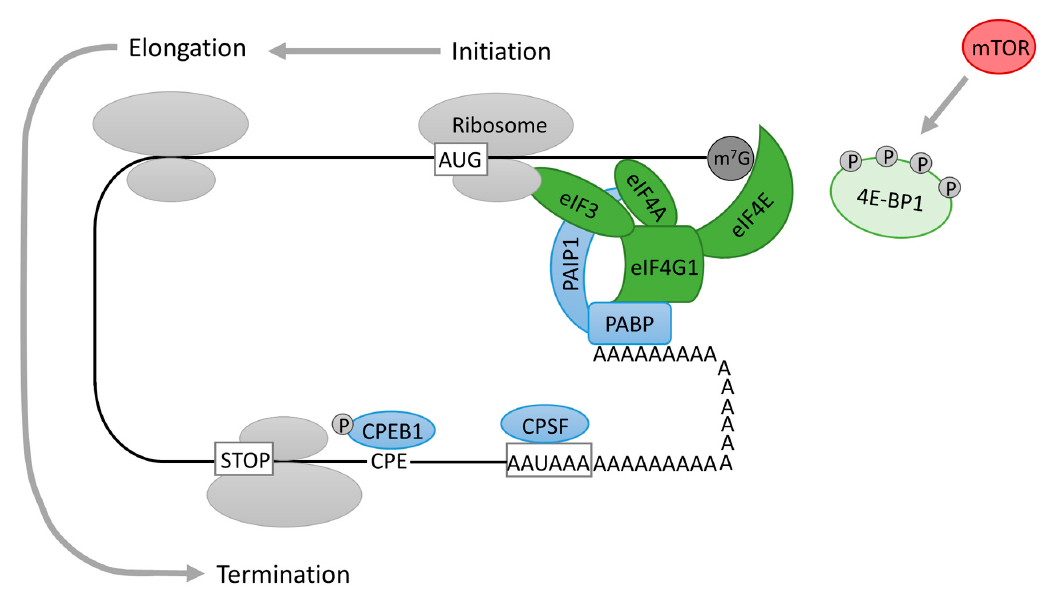
Figure 4. Scheme of a polyadenylation-induced translation. The cytoplasmic polyadenylation element (CPE) attaches to the cytoplasmic polyadenylation element binding protein 1 (CPEB1). Activated CPEB1 stabilizes the binding of activated cytoplasmic polyadenylation specific factor (CPSF) to the hexanucleotide sequence. Subsequently, CPSF recruits poly(A) polymerase (PAP) to the end of mRNA, where PAP catalyses poly(A) addition. eIF4E binding protein 1 (4E-BP1), when hyperphosphorylated by mammalian target of rapamycin (mTOR), dissociates from eukaryotic translation initiation factor 4E (eIF4E) and the formation of the eukaryotic translation initiation complex 4F (eIF4F) complex is enabled. Elongated poly(A) tail associates with a cytoplasmic poly(A) binding protein (PABP), which in turn stabilizes the cap binding eIF4F consisting of the mRNA cap-binding protein eIF4E, scaffolding protein eIF4G1 and RNA helicase (eIF4A). PABP binds poly(A) binding protein interacting protein 1 (PAIP1), which can bind eIF4A and the ribosome recruiting eukaryotic translation initiation factor 3 (eIF3). The closed loop complex enhances translation by increasing eIF4A and eIF3 recruitment. This leads to enhanced translation mediated by the poly(A) tail. Factors associated with cap-dependent translation initiation are depicted in green, poly(A) tail factors in blue, and kinases in